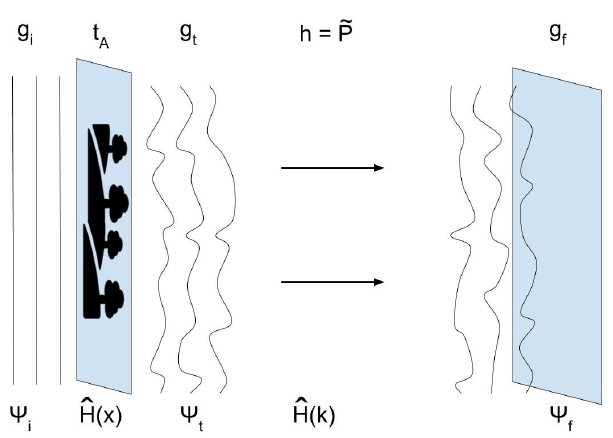
Figure A1. Visual comparison between wavefront propagation in SDT and wavefunction propagation in QM. The incoming wave (SDT optical wavefront, g i , or QM wavefunction, Ψ i ) impinges upon a diffractive element (aperture a T to be imaged in SDT, or potential ˆ H ( x ) in QWP). The resulting modified waveform ( g t in SDT or Ψ t in QWP) propagates via application of a phase factor in k -space (the impulse response ( h ) or the Fourier-transformed pupil function ( ˜ P ) in SDT, or the kinetic term of the Hamiltonian ˆ H ( k ) in QWP), resulting in a final waveform ( g f hitting a screen or film in SDT, or Ψ f indicating an updated state of the particle in